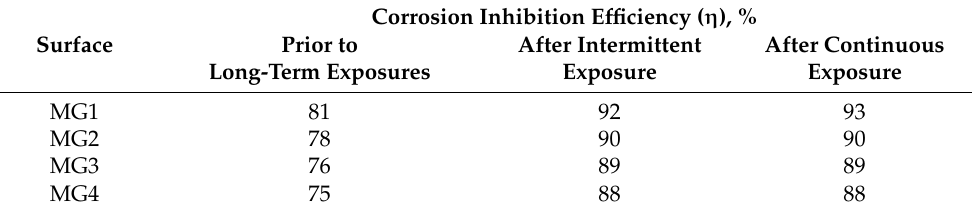
Table 5. Corrosion inhibition efficiency ( η ) of MG (Equation